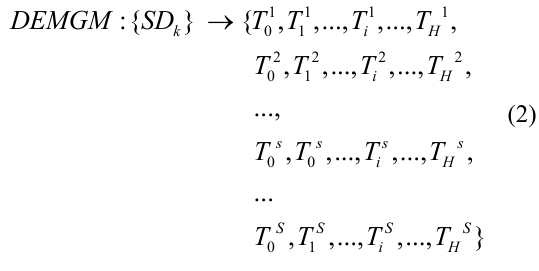
Table 1. Nominal processing time per process plan Nominal Processing Time Process Plan